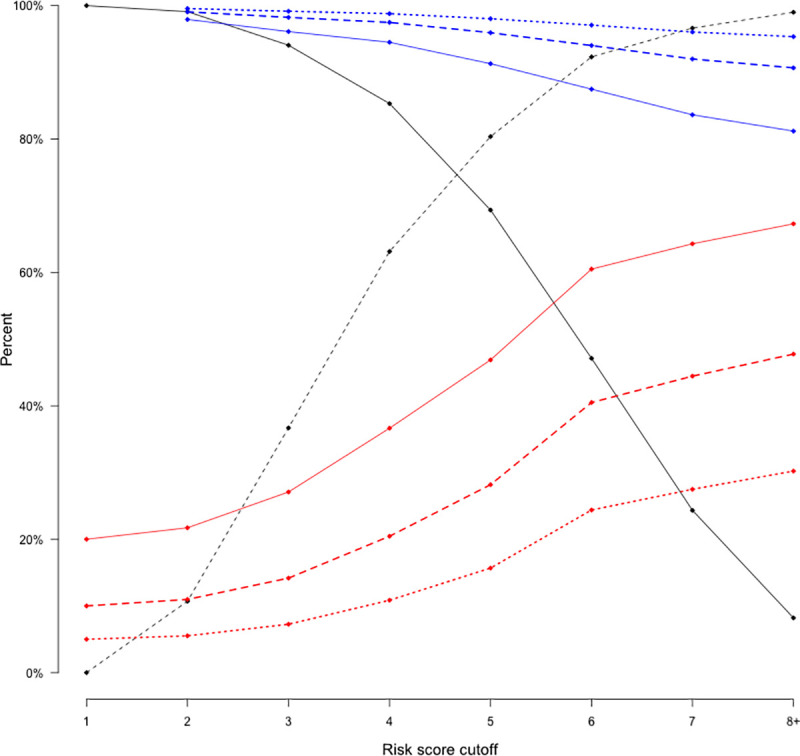
Accuracy of a simple clinical risk score for active pulmonary TB.This figure shows the sensitivity (solid black), specificity (dashed black), positive predictive values (red), and negative predictive values (blue) of a simple clinical risk score for pulmonary TB in the derivation South African cohort, at different cutoffs for a positive test. The positive and negative predictive values are estimated assuming a prevalence of TB among symptomatic individuals presenting for care (i.e., pretest probability) of 5% (dotted lines), 10% (dashed lines), and 20% (solid lines). The score ranges from a minimum of 1 to 10; see Fig 2. Due to the small sample size of individuals with scores higher than 8, we combined scores equal to or higher than 8 into 1 category. Accuracy and predictive values are calculated relative to Xpert MTB/RIF as a gold standard. TB, tuberculosis.